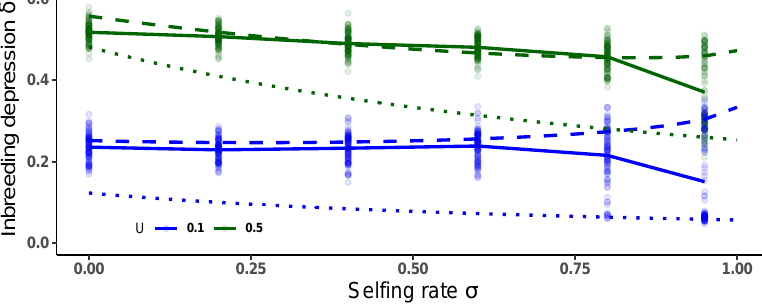
Figure 5 – Inbreeding depression δ as a function of the selfing rate for different values of the haploid mutation rate, U . Solid lines show means of the simulations run. Dotted lines show the inbreeding depression expected in the absence of overdominance (Eq. (7)) while dashed lines show increases in delta expected with overdominant selection over all selfing rates (Eq. (6)). Other parameter values are n L = 100 , ℓ = 10 − and randomly placed mutations in the POD zone. Selection coefficients in- and outside the POD zone, s and s d are set to 0.01 with dominances h and h d = 0.2 . The total map length (setting the recombination rate) is R = 10